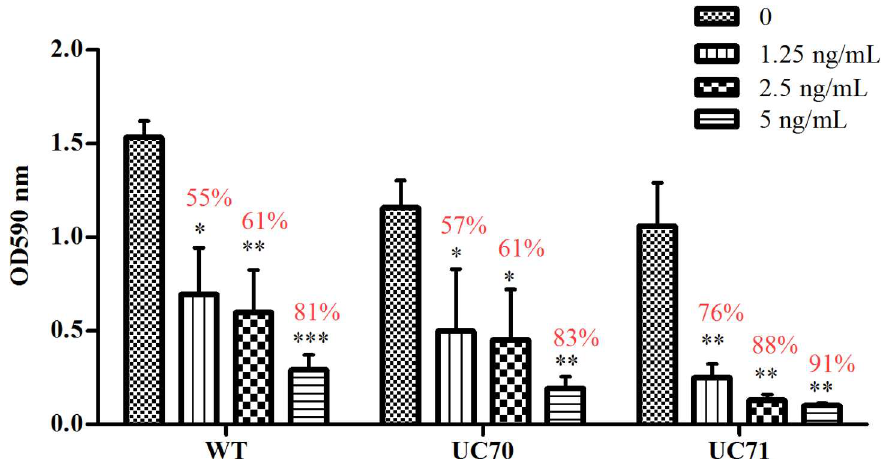
Fig 6. H . capsulatum susceptibility to itraconazole when Srb1 is silenced. Graph represents a comparison of wild-type, wild-type-vector (UC70) and Srb1 :RNAi (UC71) survival in different concentrations of itraconazole. OD600 measurement after 6 days in culture was used to quantify yeast growth. Values in red represent the percentage difference in growth comparedto no treatment group (0). Statistical analysis conducted on 3 experiments represent the mean ± SEM of OD600 absorbance of H . capsulatum in each itraconazole concentration comparedto no treatment